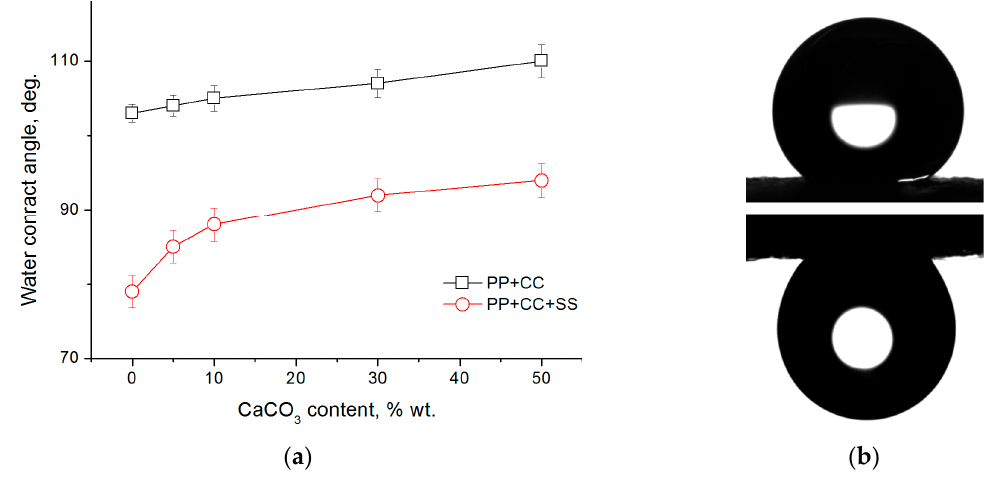
Figure 8. ( a ) Effect of CaCO3 content on the wettability of the polymeric films; ( b ) optical image of a water droplet on the surface of the (90PP+10CC)+SS nonwoven material after 60 seconds from deposition (top) and after rotating the material by 180° (bottom).